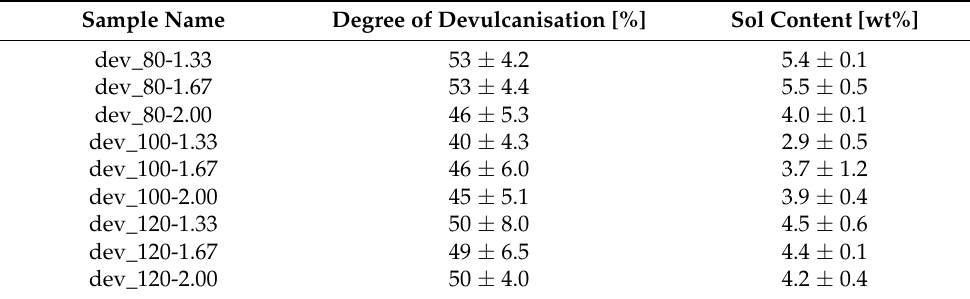
Table 5. The degree of devulcanisation and sol content of the devulcanisates.